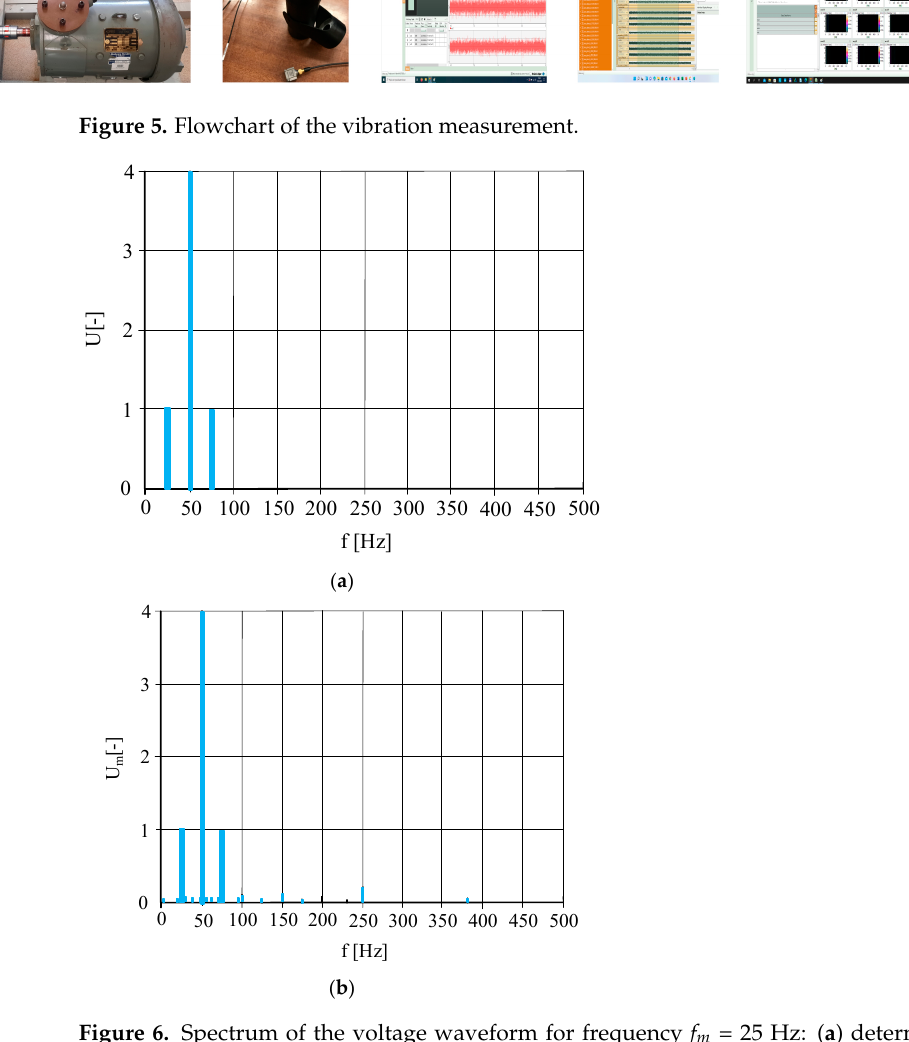
Figure 6. Spectrum of the voltage waveform for frequency f m = 25 Hz: ( a ) determined with the calculations and ( b ) the measured output from the programmable power source.